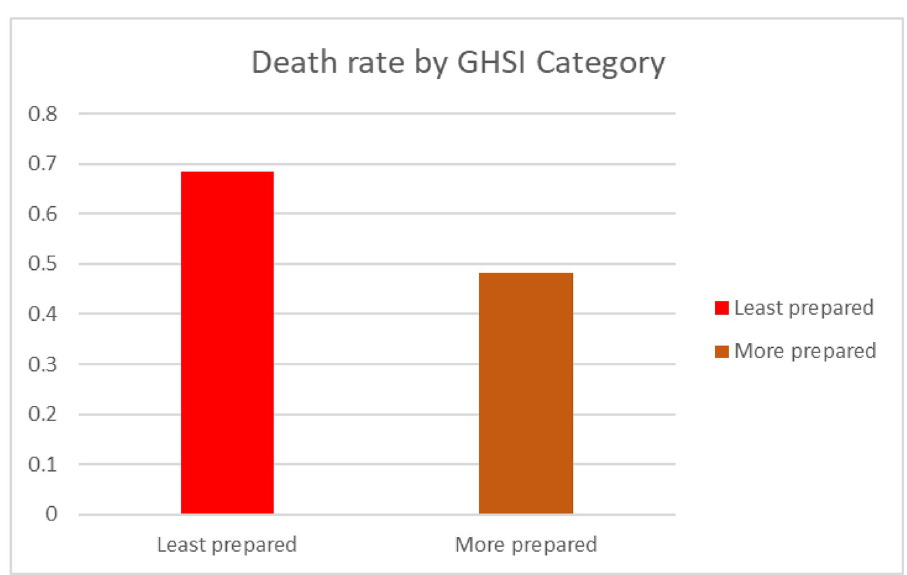
Fig 8. Death rate by GHSI category.